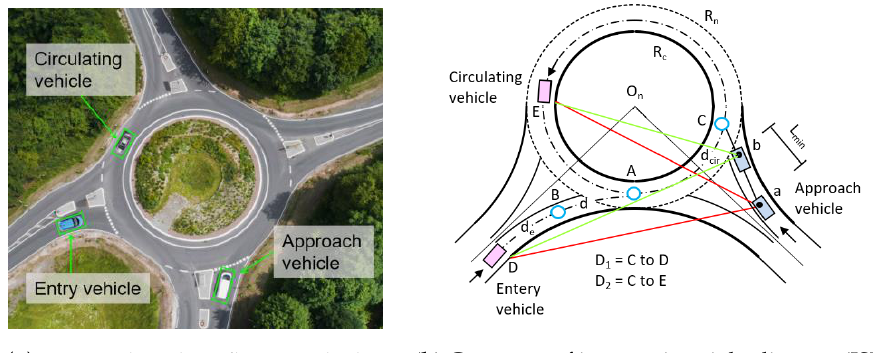
Figure 2. Illustration of the intersection sight distance. ( a ) Approach and conflicting vehicles. ( b ) Geometry of intersection sight distance (ISD).